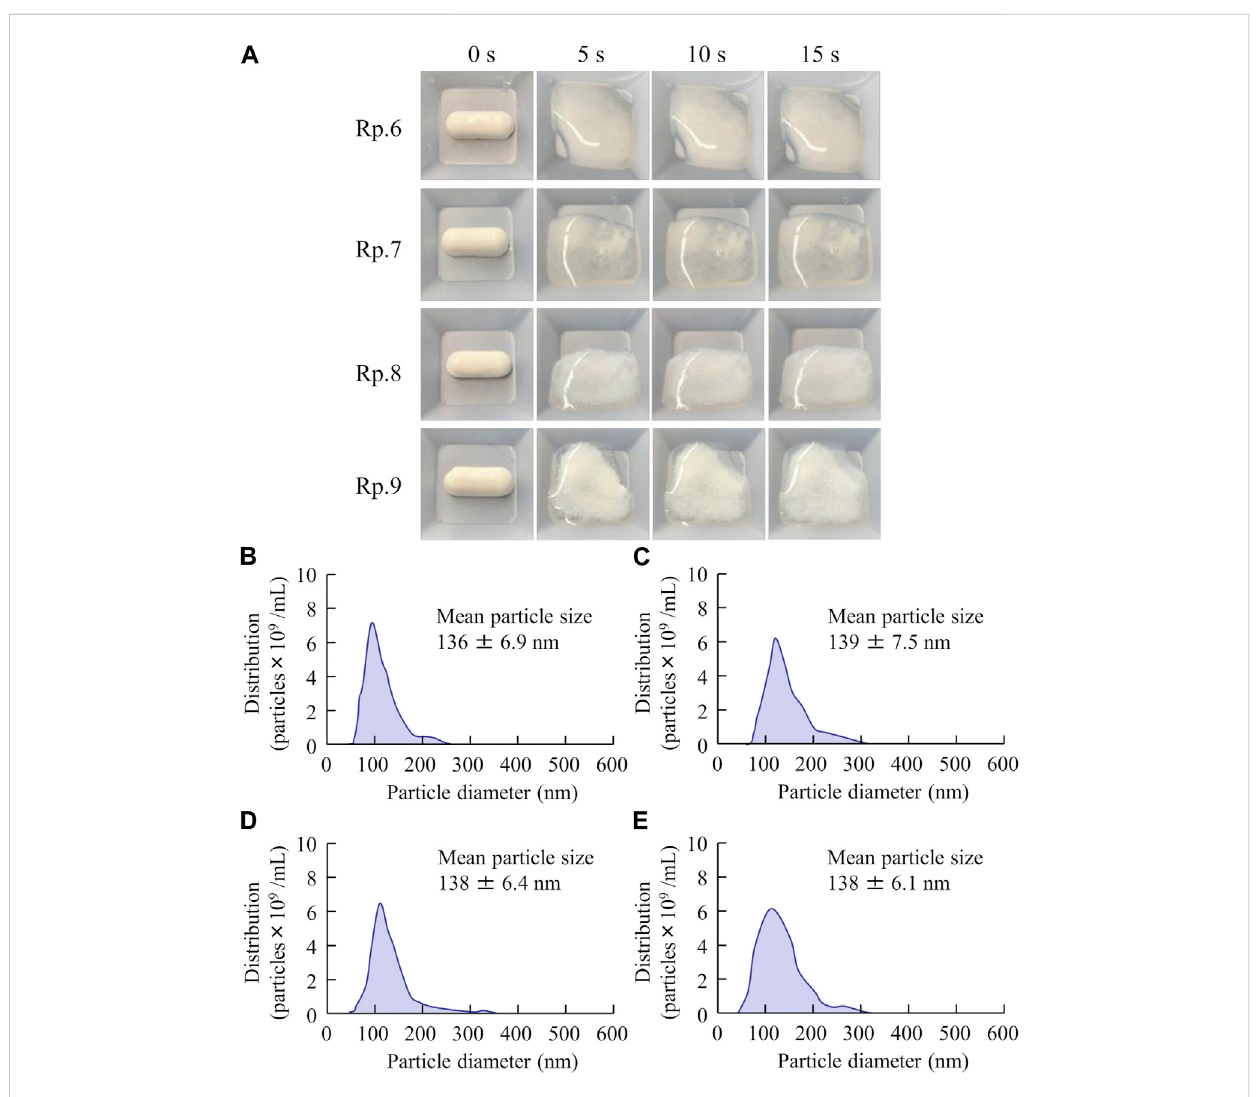
FIGURE 4 Effect of gum arabic contents on the disaggregation time and particle distribution of the FAM-NP tablets shown in Table 1. Photograph in the disaggregation process of the FAM-NP tablets (A) , (Rp. 6 – 9 formulations). Particle distribution of the redispersed Rp.6 (B) , Rp.7 (C) , Rp.8 (D) , and Rp.9 (E) formulations. The Rp.6 – Rp.9 formulations were disaggregated within 15 s after addition to puri fi ed water. The FAM particles in the redispersed FAM-NP tablet were nano-sized.